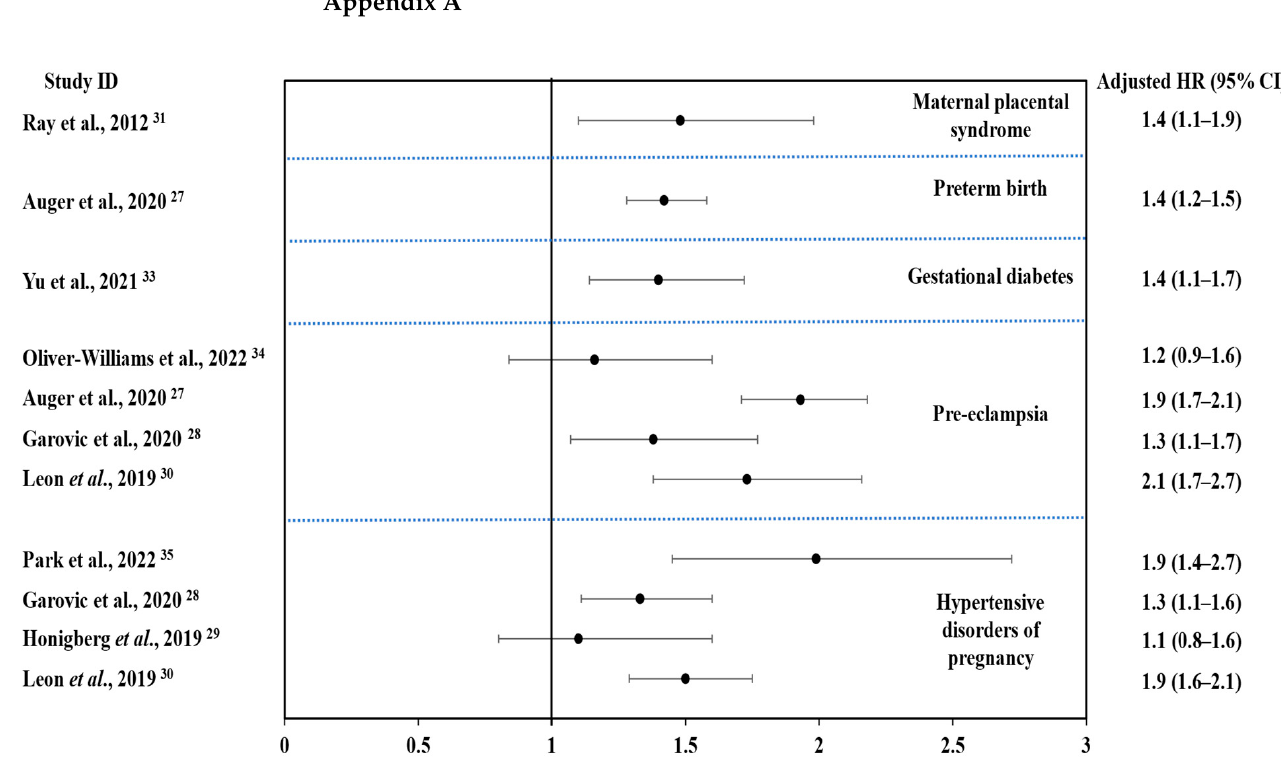
Figure A1. Forest plot summarising the adjusted hazard ratios between pregnancy complications and incident atrial fibrillation by the pregnancy complication sub-type.